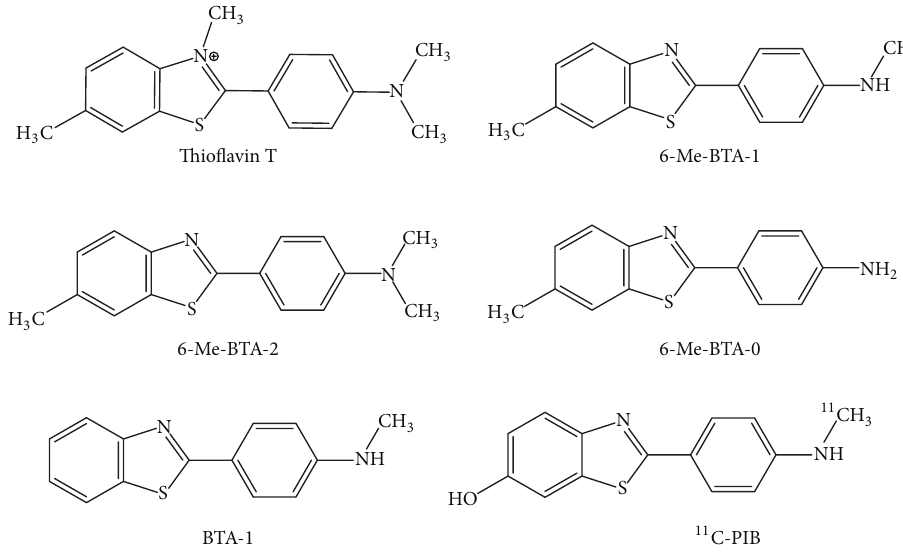
Scheme 2: Chemical structures of thioflavin T and its derivatives, useful for potential in vivo imaging for 𝛽 -amyloid